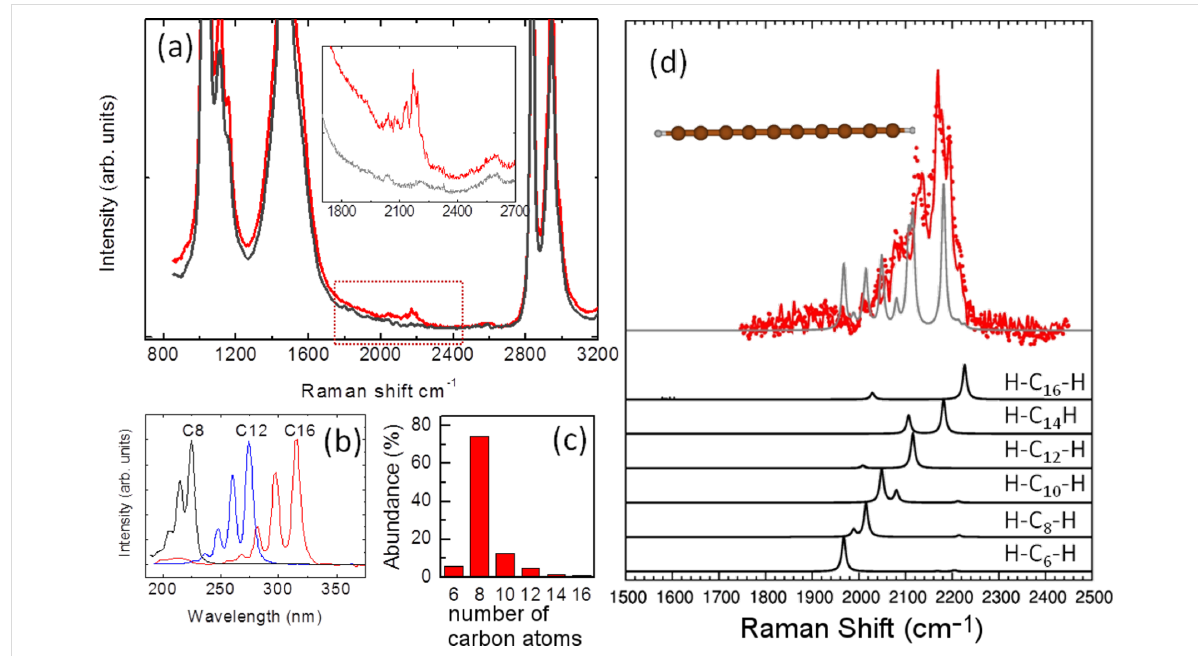
Figure 4: (a) Experimental Raman spectrum (1064 nm) of H-capped polyynes in methanol (5 × 10 − 3 M), with the pure solvent shown for comparison. (b,c) UV–vis spectra for polyynes of different lengths and size distribution in the sample solution. (d) DFT-computed Raman peaks for polyynes present in the sample weighted by their correspondent abundance and comparison with the experimental spectrum. Figure adapted with permission from [76], copyright 2006